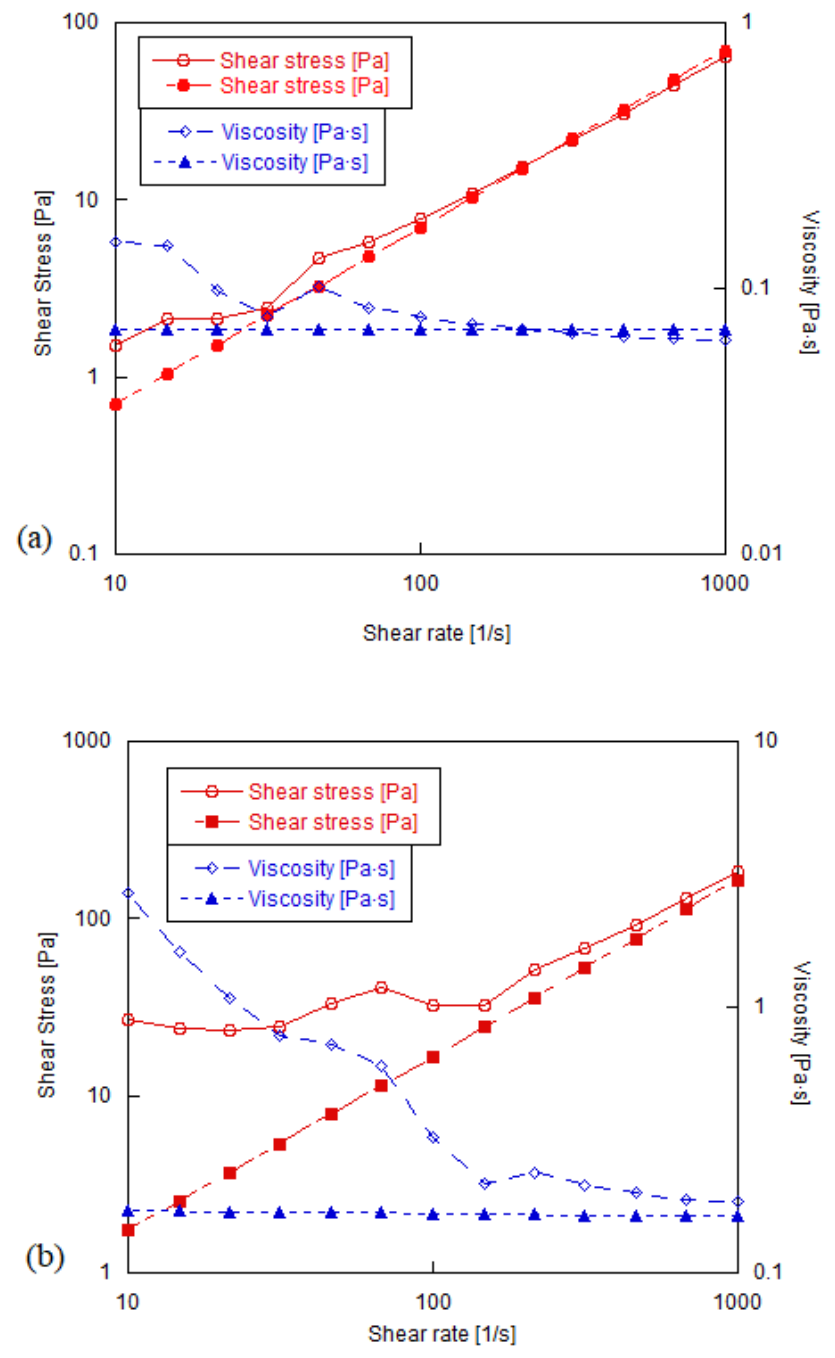
Figure 8. Stability tests for suspensions with concentrations of ( a ) 0.1 and ( b ) 80 mg / mL of GO 2 h comparing suspensions with agitation (filled symbols) and without agitation (open symbols).